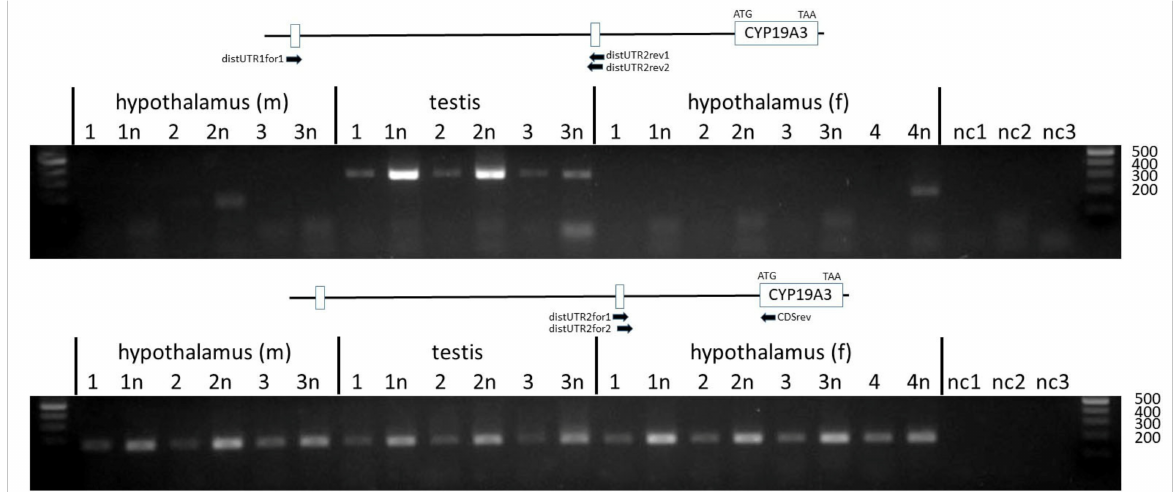
Figure 5. PCR products amplified with primers annealing to the distal untranslated exons 1 and 2 and to the CDS. Products Figure 2. and the CDS were found in all tissue samples. Sizes of respective markers in base pairs are